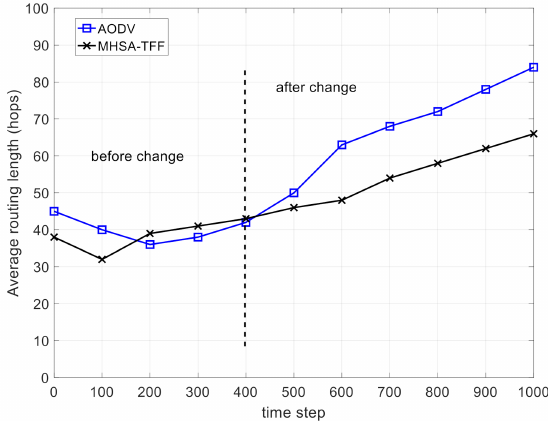
Figure 5. The comparison on the average routing